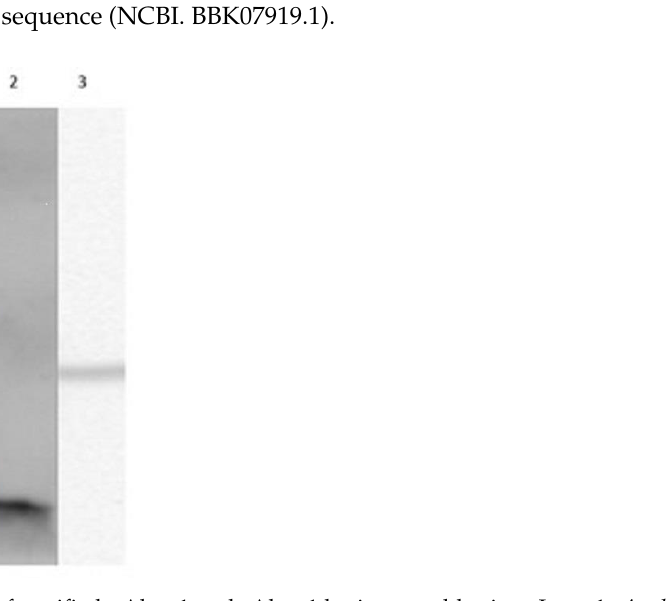
Figure 1. Identification of purified nAlt a 1 and rAlt a 1 by immunoblotting. Lane 1: A. alternata extract, Lane 2: purified nAlt a 1, Lane 3: purified rAlta 1. M: Molecular weight marker .